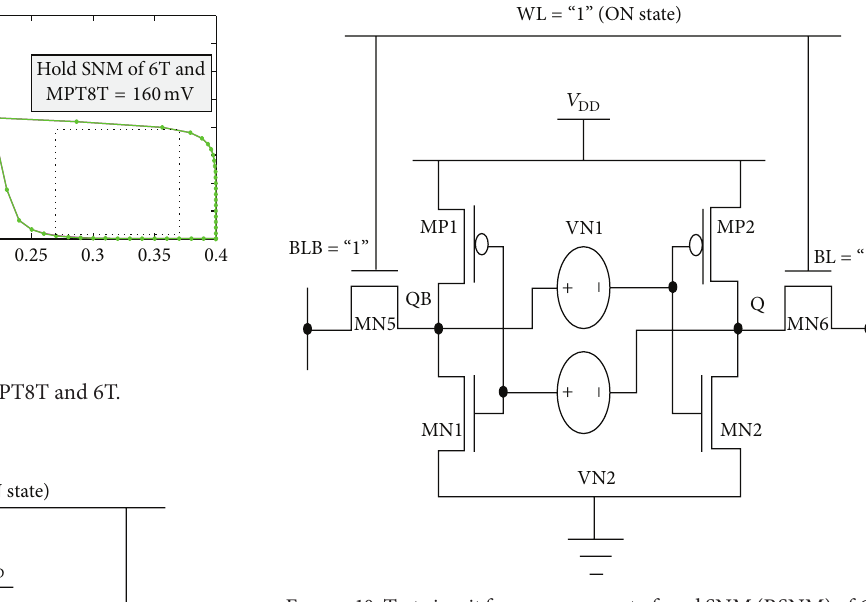
Figure 10: Test circuit for measurement of read SNM (RSNM) of 6T.